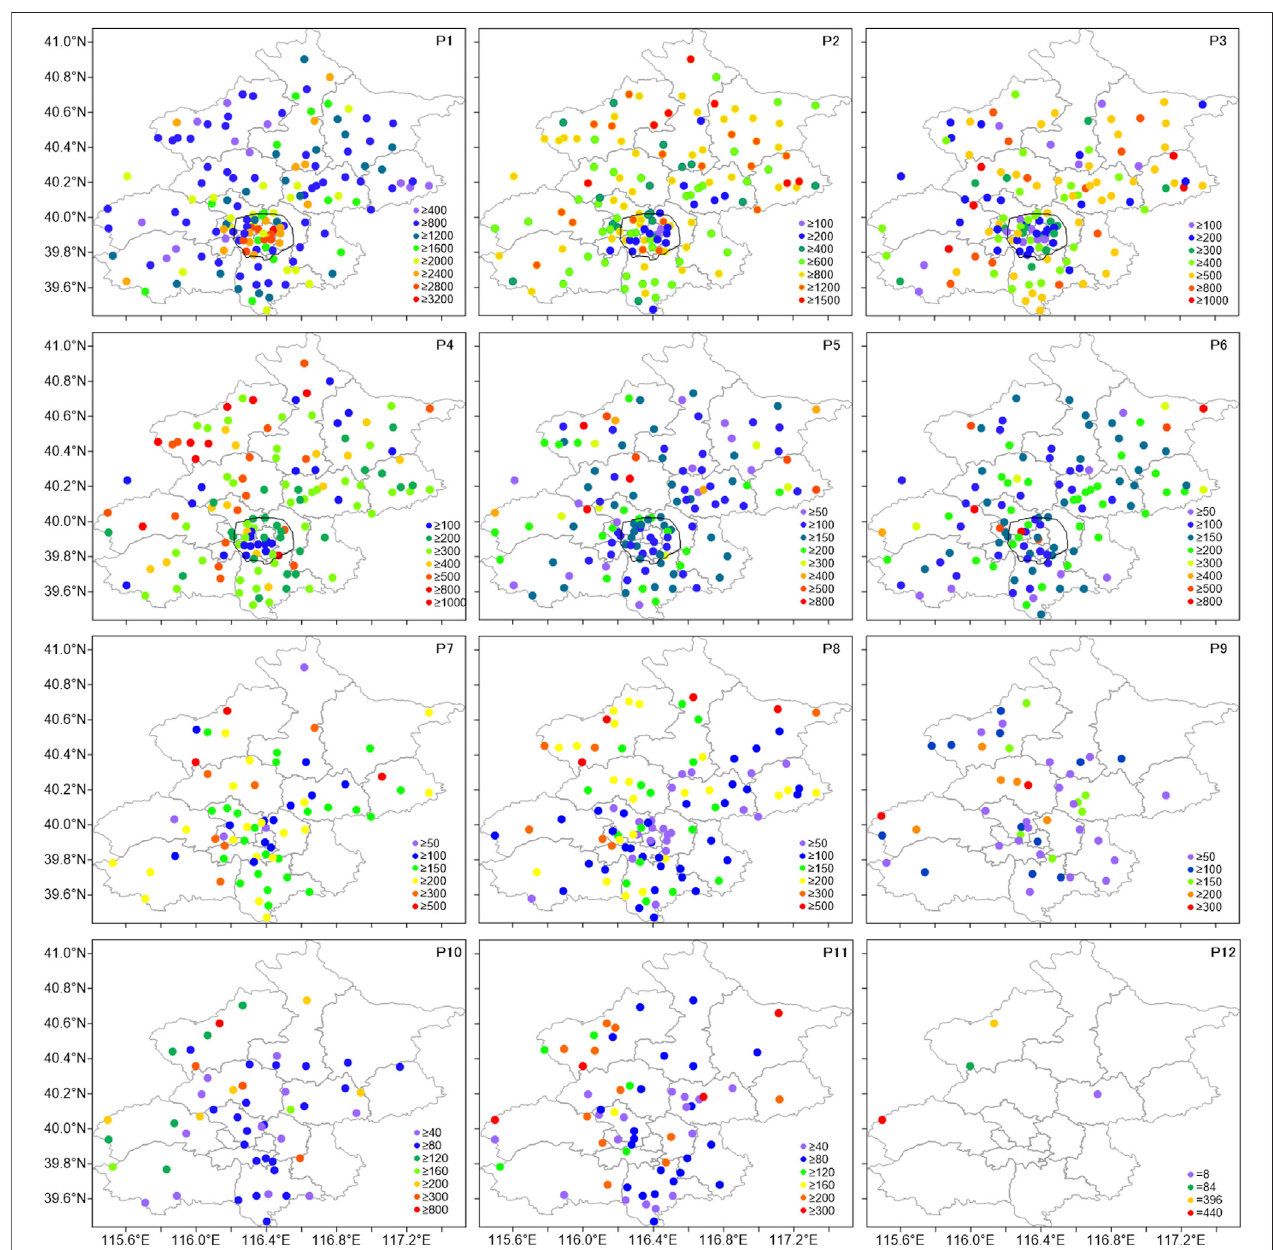
FIGURE 12 | Cluster frequency at different stations. The black line is the Fifth Ring